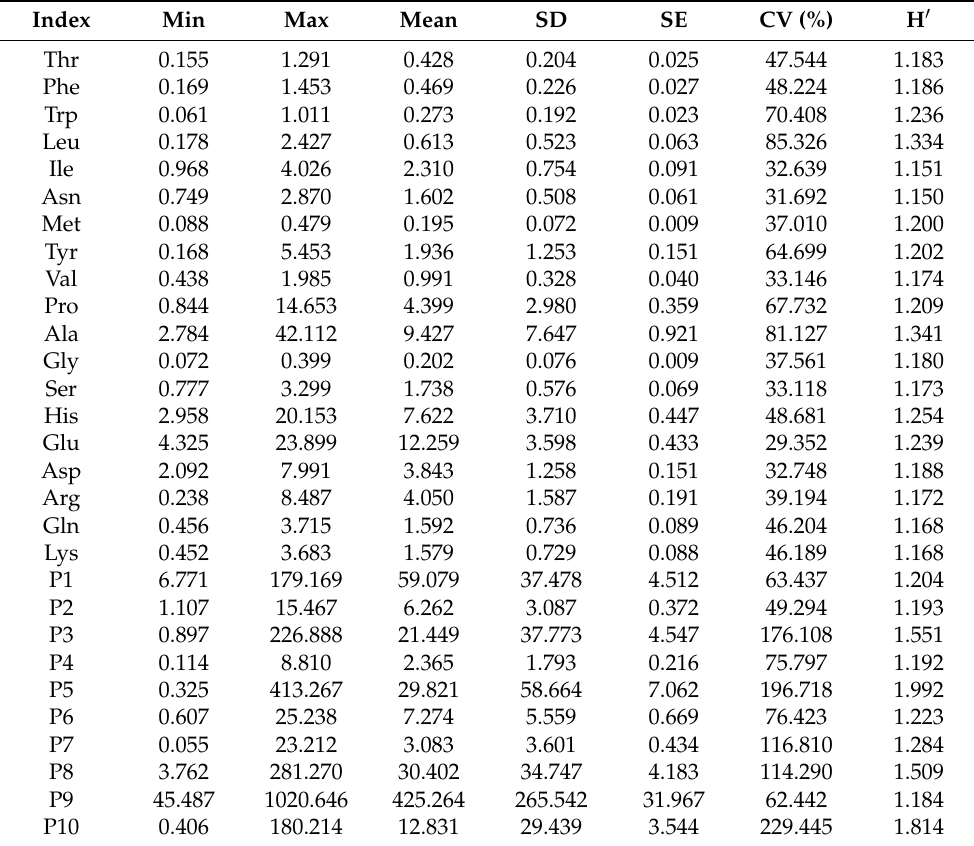
Table 1. Estimates of descriptive statistics (including the min, max, mean, SD, SE, CV, and H (cid:48) ) for the leaf-free amino acids (mg/g dry matter) and polyphenol ( µ g/g dry matter) contents of 69 cabbage